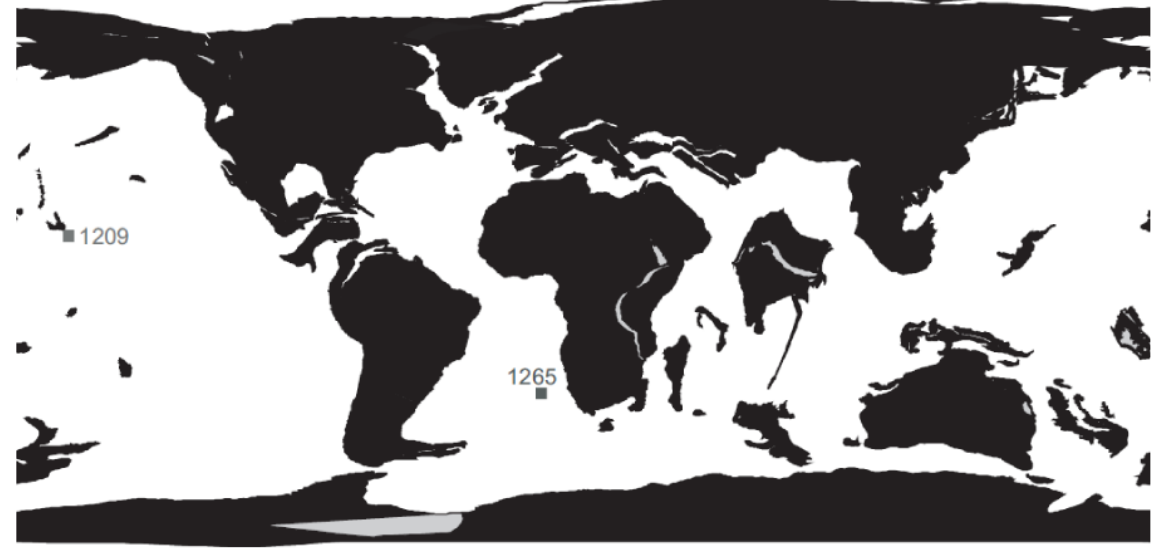
Fig. 1. (a) Map showing the paleogeographic reconstruction for the Early Eocene with the location of ODP Sites 1265 and 1209